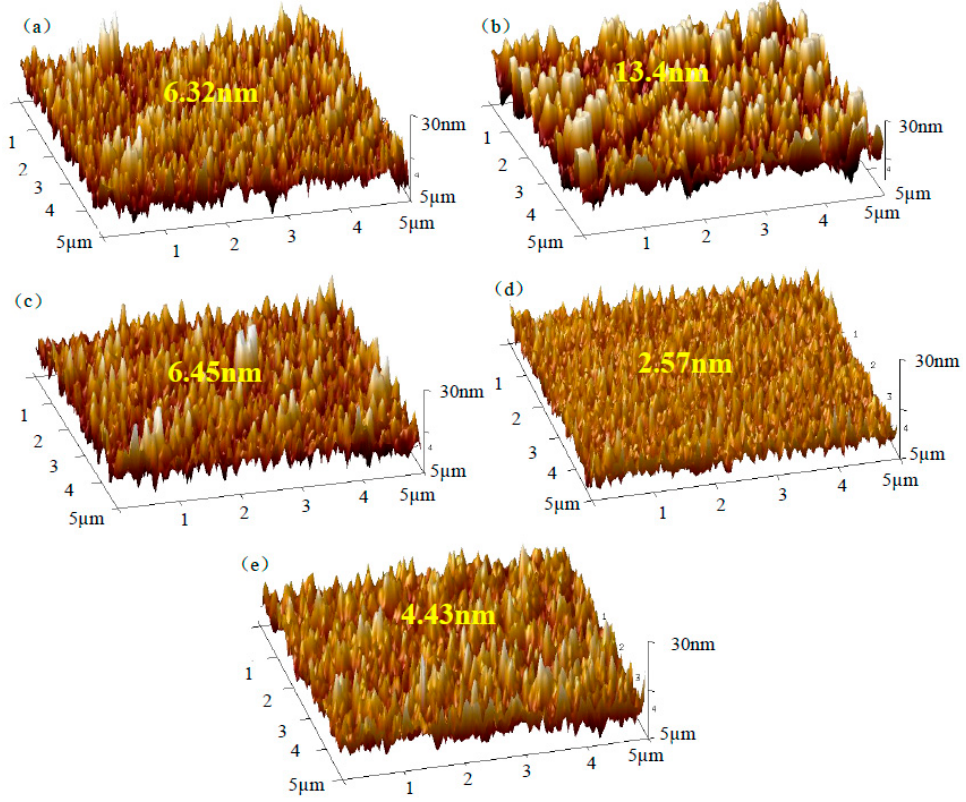
Figure 7. The three-dimensional surface morphology of the LZO piezoelectric thin films under different Li doping concentrations: ( a ) pure ZnO; ( b ) 3 wt% LZO; ( c ) 5 wt% LZO; ( d ) 8 wt% LZO; ( e ) 10 wt% LZO.